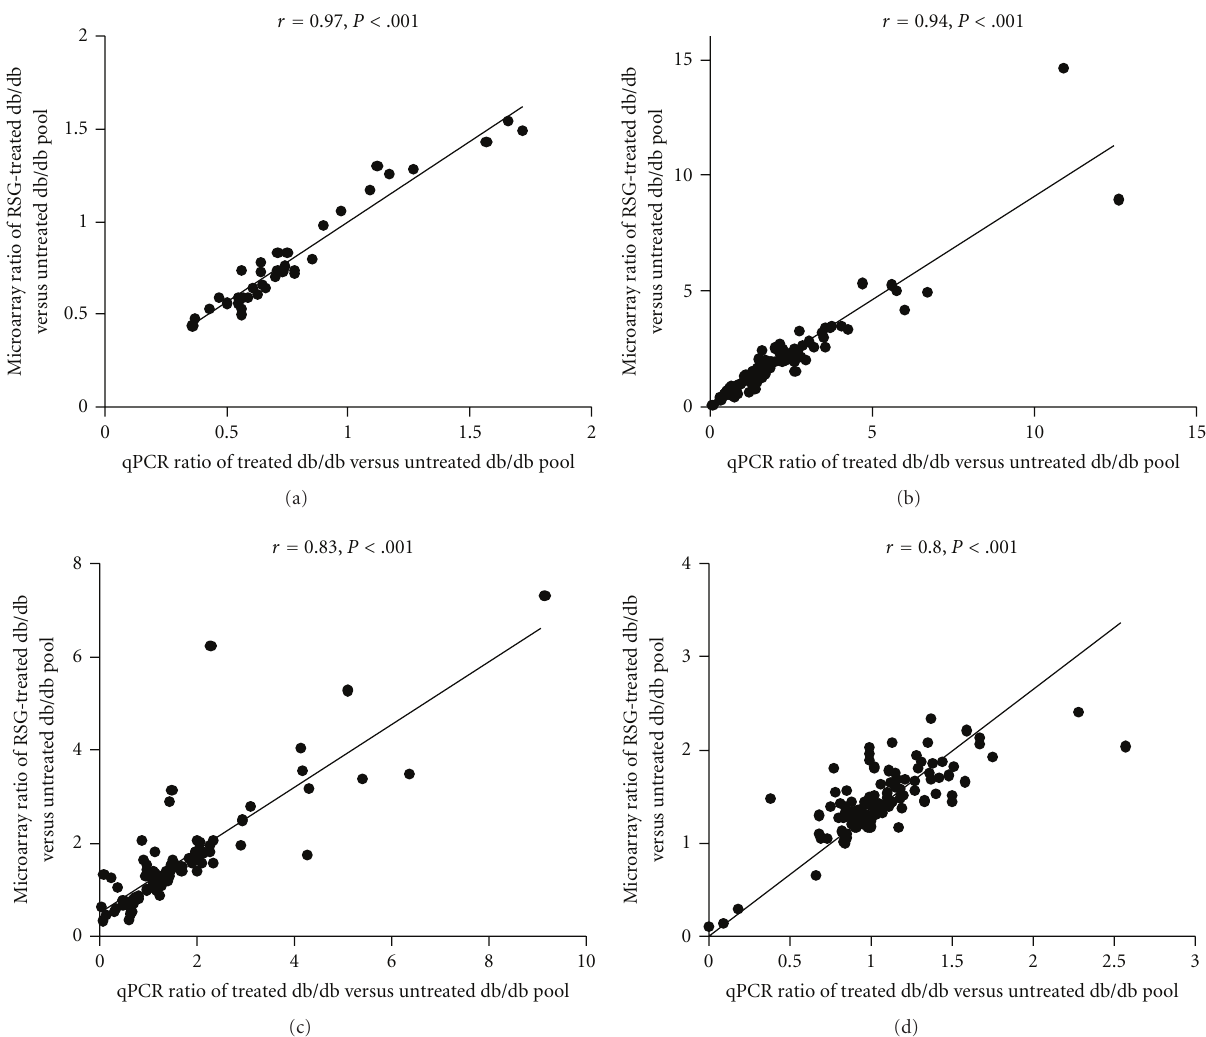
Figure 2: Correlation plot between microarray and qPCR data. Genes involved in (a) liver carbohydrate metabolism, (b) liver FA and TG metabolism, (c) IAT FA and TG metabolism, and (d) IAT citrate cycle and oxidative phosphorylation. Microarray ratio of di ff erentially expressed genes in db/+ and RSG-treated db/db versus untreated db/db mice were plotted on the y -axis and qPCR ratio data on the x -axis. Correlations were assessed using Pearson’s correlation coe ffi cient ( r ) and P -value <